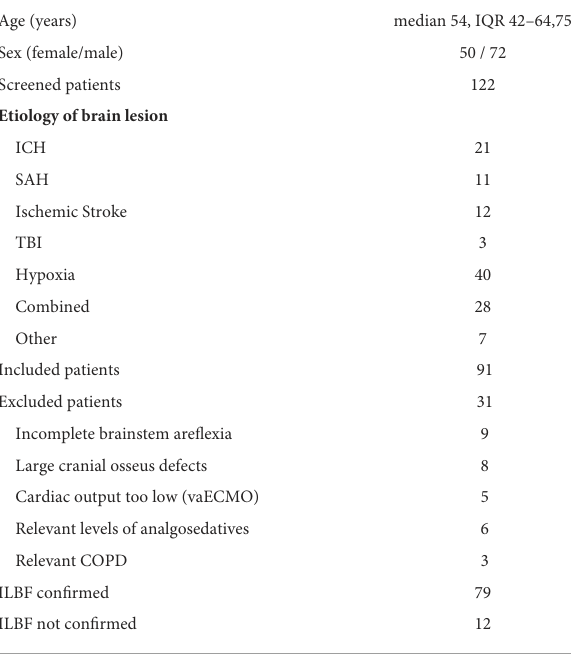
TABLE 1 Patient characteristics of all 122 screened patients and further details of the ILBF